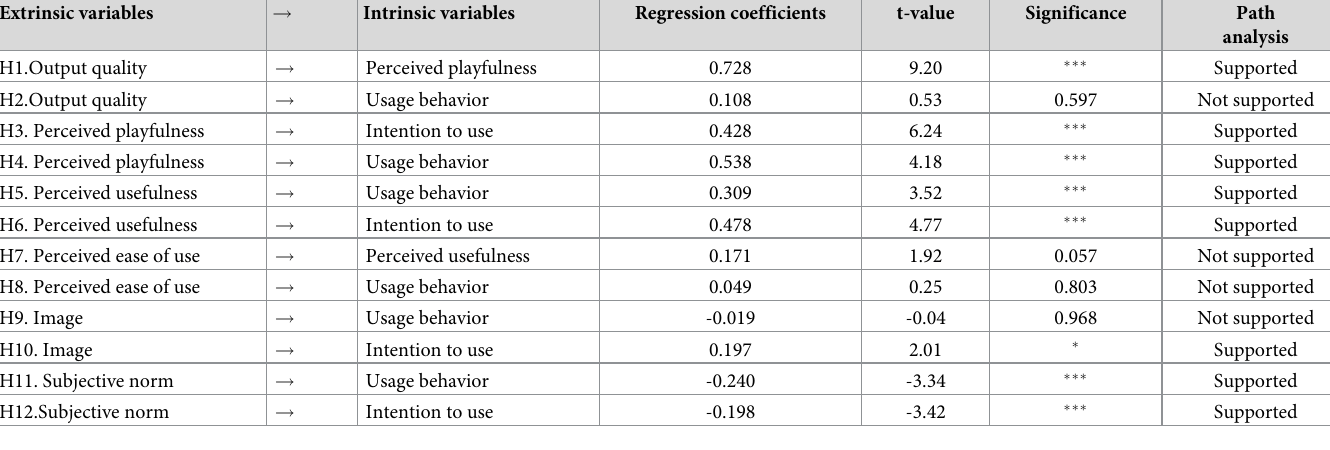
Table 8. TAM2 analysis of research hypotheses pertaining to physical